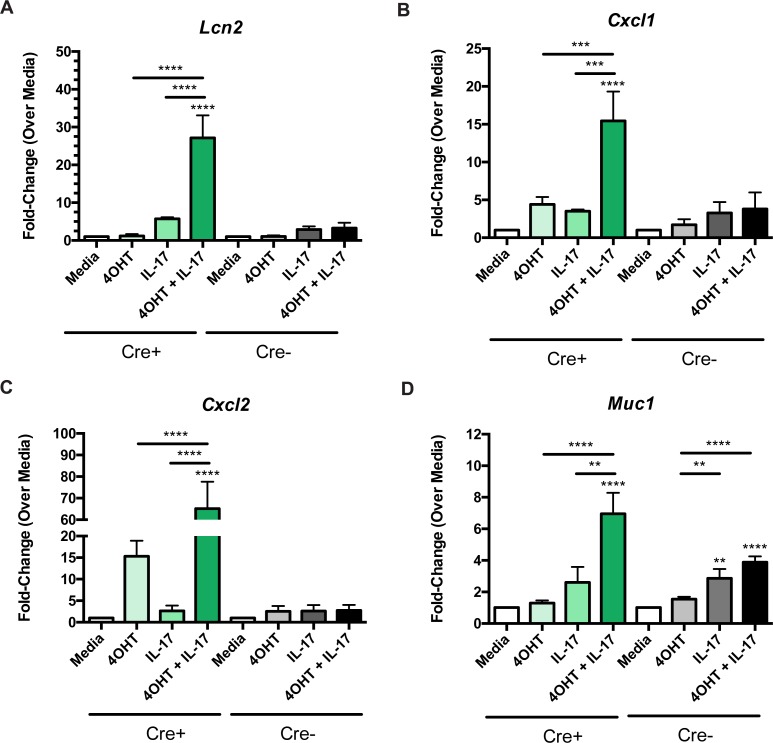
Deletion of A20 enhances the proinflammatory effects of IL-17A.Gene expression of (A) Lcn2, (B) Cxcl1, (C) Cxcl2, (D) Muc1 by qPCR of organoid cultures after 24 hours of 4OHT treatment and/or a 12 hour stimulation with recombinant IL-17A. Cre+ or Cre- conditions were tested separately by ANOVA. Pairwise comparisons were completed post-hoc using t-tests and correcting for multiple comparisons by the Scheffe method (see also S2 Table). Stars above each column indicate statistical significance relative to the media condition of the same organoid line (Cre+ or Cre-) by a t-test. Bars with stars indicate statistically significant differences between the two indicated conditions. **P≤0.01, ***P≤0.001, ****P≤0.0001.